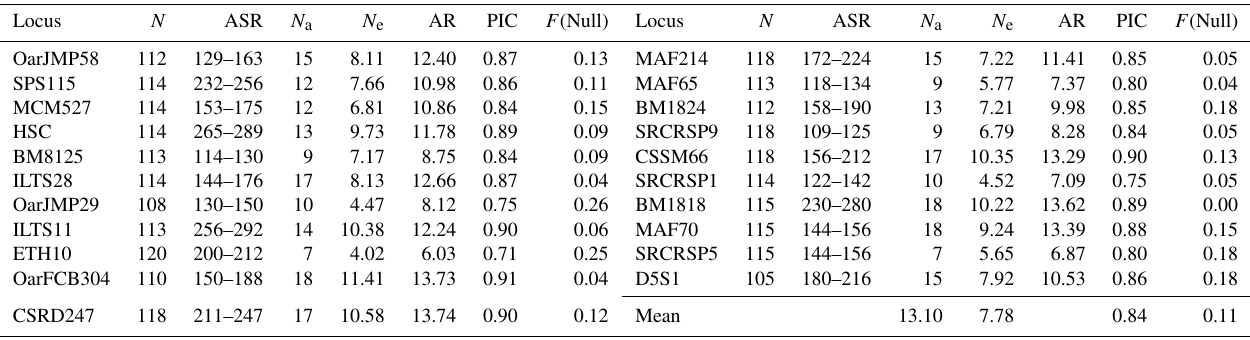
Table 1. Descriptive statistics for genetic diversity over 21 microsatellite loci in four local Turkish sheep populations.